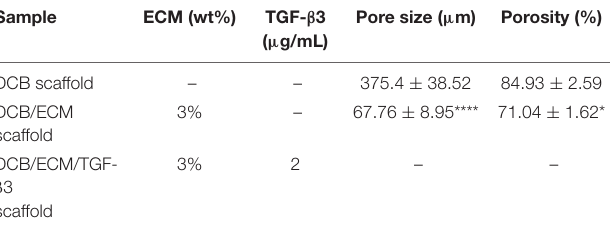
was perfused with 20 µ L of 20 µ g/mL TGF- β 3 and incubated subsequently at 4 ◦ C for 20 min to form the DCB/ECM/TGF- β 3 scaffold according to a previous study (Huang et al., 2018) ( Figure 1